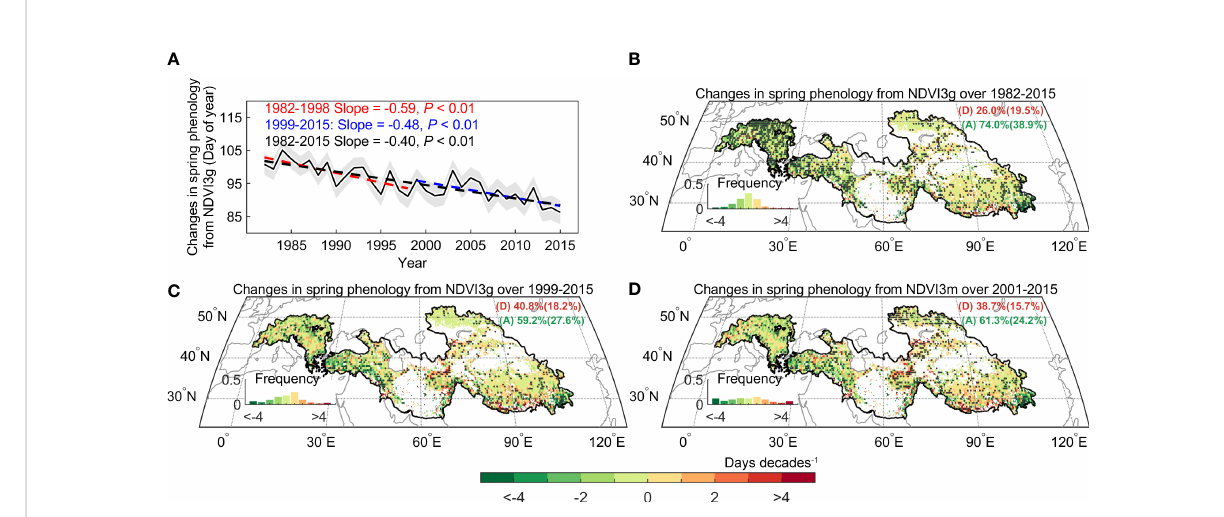
FIGURE 4 Spatial distribution of changes in spring phenology over the Pan-Third Pole. (A) Changes in regionally spring phenology across Pan-Third Pole over the period 1982 – 2015. (B) Changes in spring phenology derived from GIMMS Normalized difference vegetation index (NDVI3g) during 1982 – 2015 (C) , 1999 – 2015 (D) , and from Moderate Resolution Imaging Spectroradiometer (MODIS) C6 (NDVIm) during 2001 – 2015. The dots indicate the regions with a signi fi cant trend in spring phenology ( P<